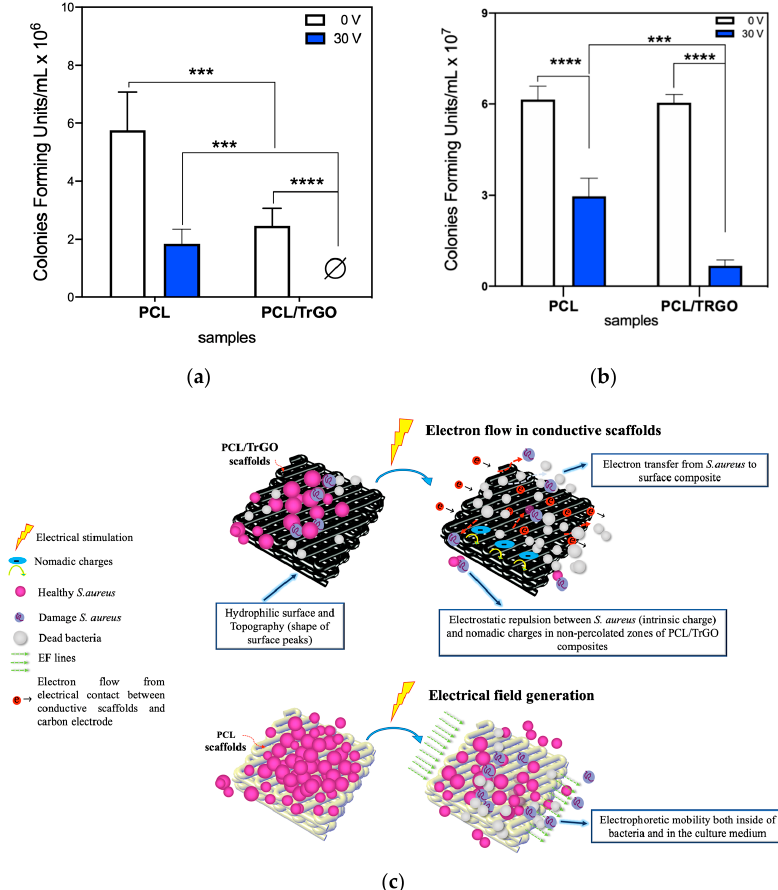
Figure 7. ( a ) Colony-forming units (CFU) graph of the antibacterial tests with (30 V) and without electrical stimuli (0 V) for 3 h. The symbol Ø on the PCL / TrGO at 30 V denotes nondetectable values, (n = 4 independent experiments in triplicate); ( b ) bacterial CFU in the culture media (sca ff olds removed from bioreactor) after 3 h of incubation at 0 V and 30 V. ** and *** denote a significant di ff erence with a value p < 0.001 and p < 0.0001, respectively, with the control sample PCL 0 V and between tche samples indicated, n = 3 independent experiments were performed in triplicate per sample; ( c ) schematic representation of the possible mechanisms of antibacterial e ff ects at 0 V for PCL / TrGO and under conditions of electrical stimulation (ES) at 30 V for sca ff olds of PCL and PCL /